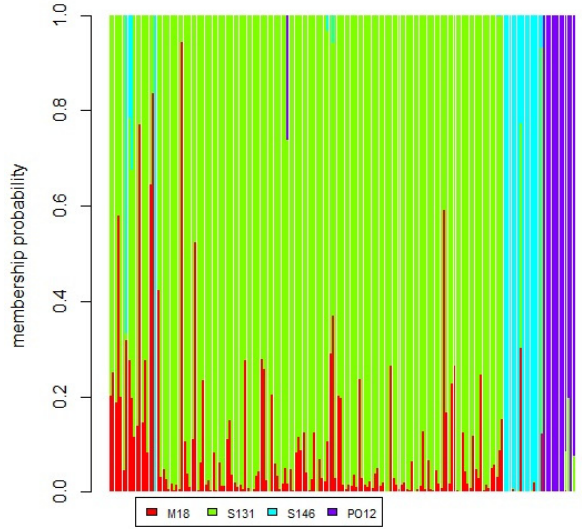
Figure 6. Bayesian approach results using the discriminant analysis of principal components to investigate genetic structure. M18, Simmental Purebred; S131, Simmental Cross-West Sumatra; S146, Simmental Cross-West Java; PO12, Ongole Grade (PO)